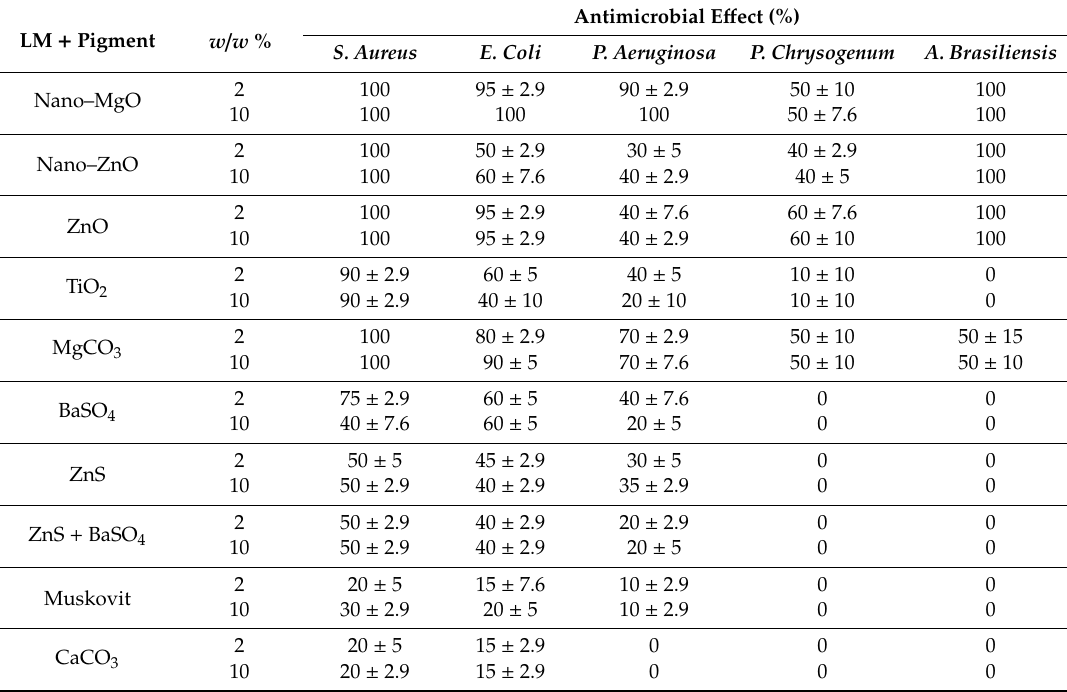
Table 9. Antimicrobial e ff ect of LM coating films.